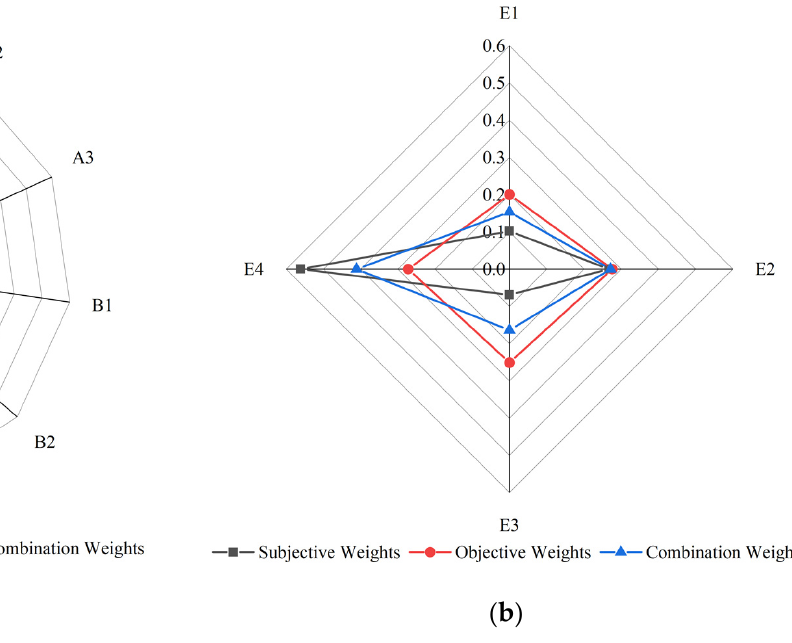
Figure 4. Weight proportion of each indicator. ( a ) Description of weight proportion of each indicator at target layer T1; ( b ) description of weight proportion of each indicator at target layer T2.